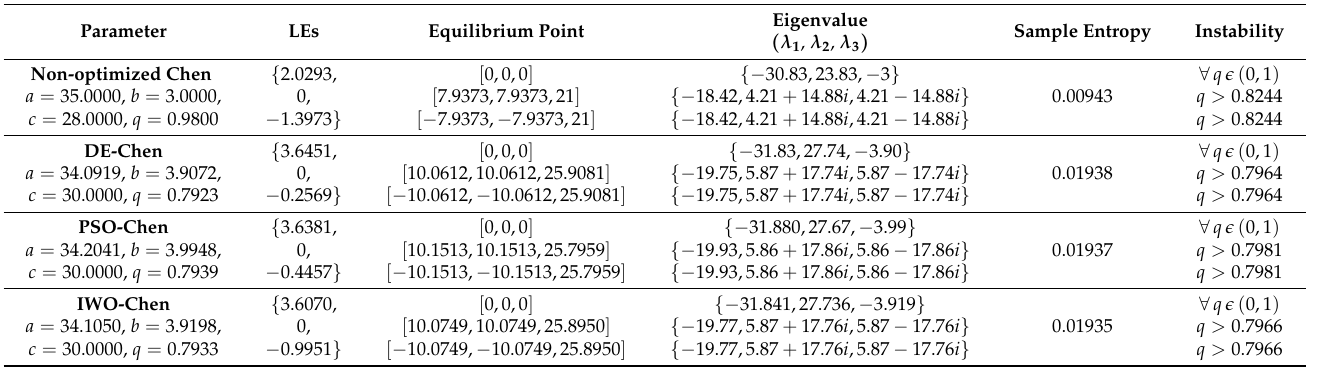
Table 1. The optimization results showing the optimized fractional order chaotic Chen system by DE, PSO, and IWO against the non-optimized system.